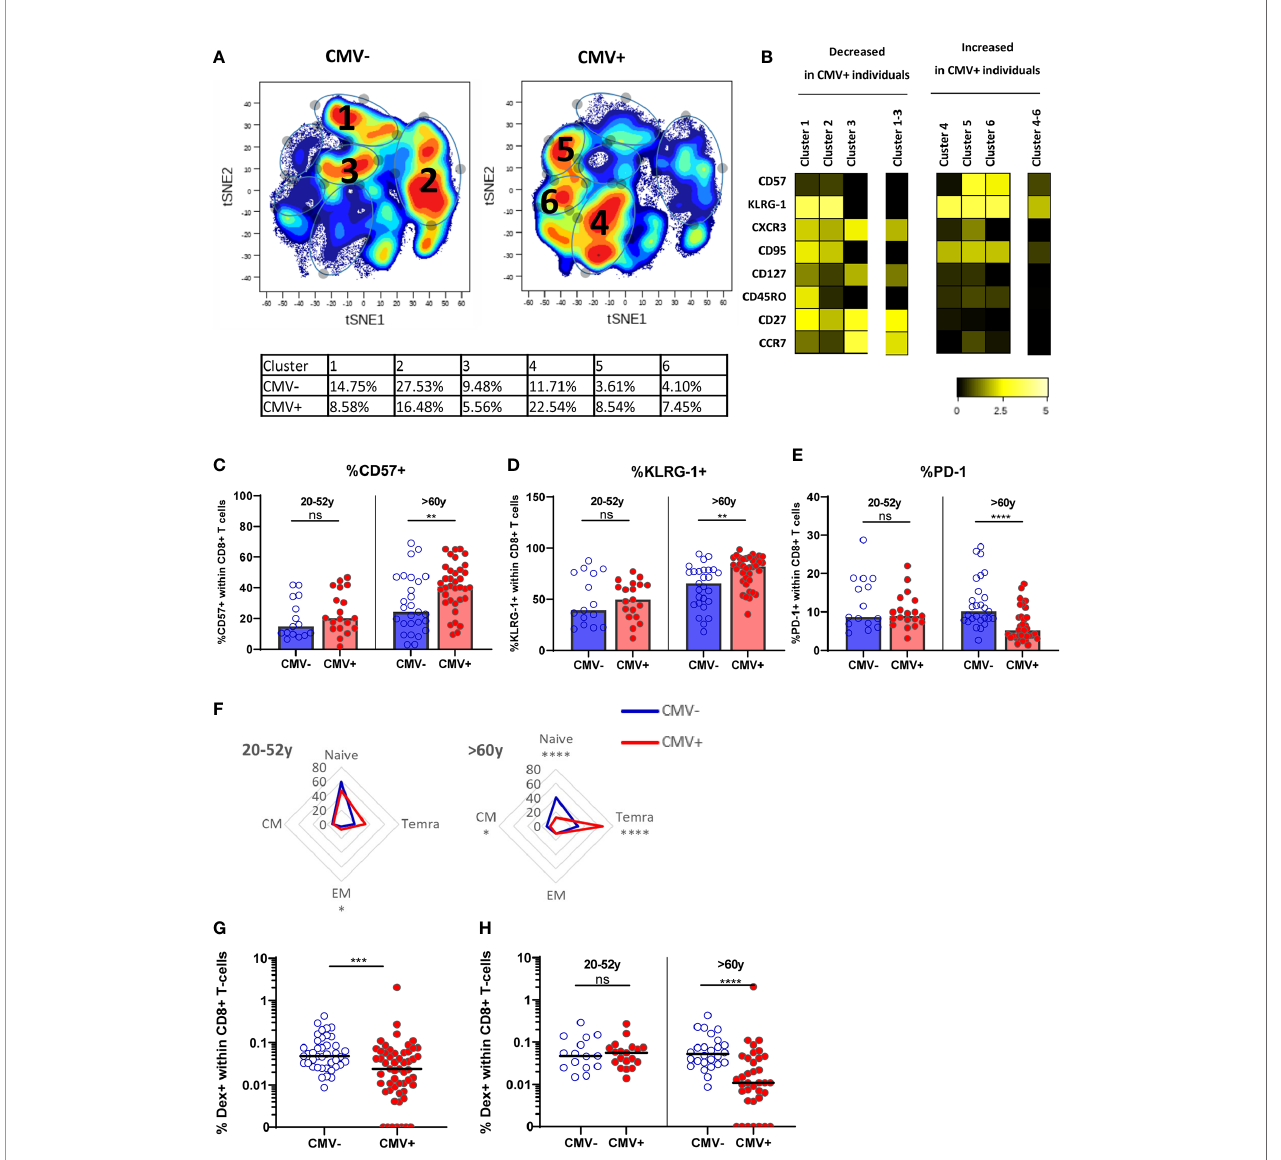
FIGURE 1 | The effect of CMV on memory CD8 + T cells and IAV-speci fi c CD8 + T cells in older adults. (A) t-SNE analysis of total CD8 + T cells based on MFI of CD57, KLRG-1, CXCR3, CD95, CD127, CD45RO, CD27 and CCR7 in CMV - and CMV + individuals (total of n = 96). (B) Heatmap of expression of markers of t-SNE clusters. Differences between CMV - and CMV + individuals is tested in Supplementary Figure 1A . (C – E) Percentage of CD57 + (C) , KLRG-1 + (D) or PD-1 + (E) CD8 + T cells in young and old CMV - and CMV + individuals. (F) Distribution of CD8 + T cells over naive and memory subpopulation in CMV - and CMV + individuals categorized in young (left panel) and old (right panel) adults. (G) Percentage of IAV-speci fi c CD8 + T cells in all CMV - and CMV + individuals. (H) Percentage of IAV- speci fi c CD8 + T cells in CMV - and CMV + individuals categorized in young and old individuals. Median is presented in each fi gure. Differences between groups were compared by Mann Whitney U test. **P < 0.01, ***P < 0.001, ****P < 0.0001. ns, non signi fi